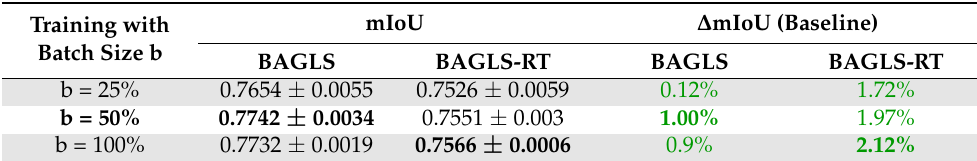
Table 5. Segmentation performance of the U-Net after incremental finetuning with knowledge distillation and the static teacher